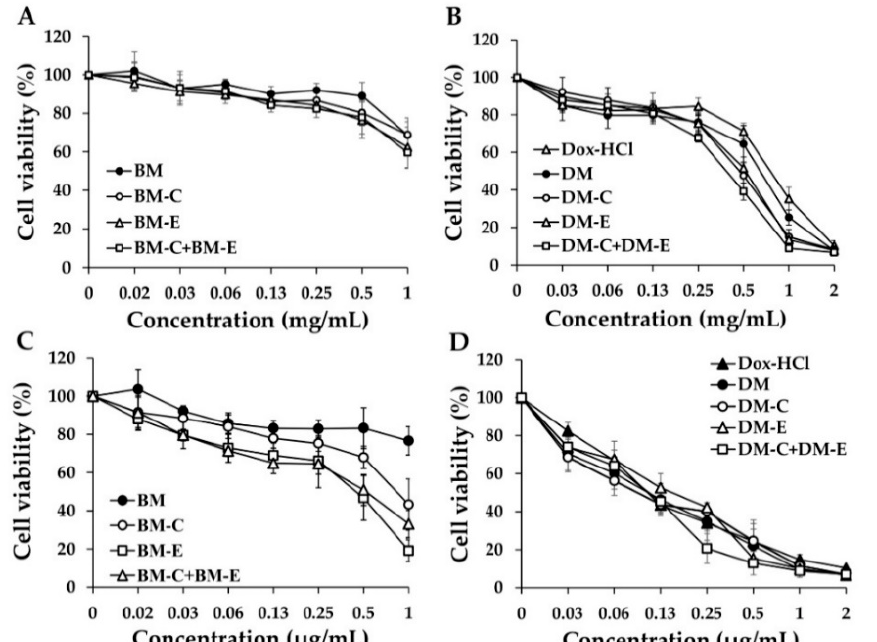
Figure 11. Cytotoxicity of blank-micelle (BM), BM-CKR (BM-C), BM-EVQ (BM-E), and BM-